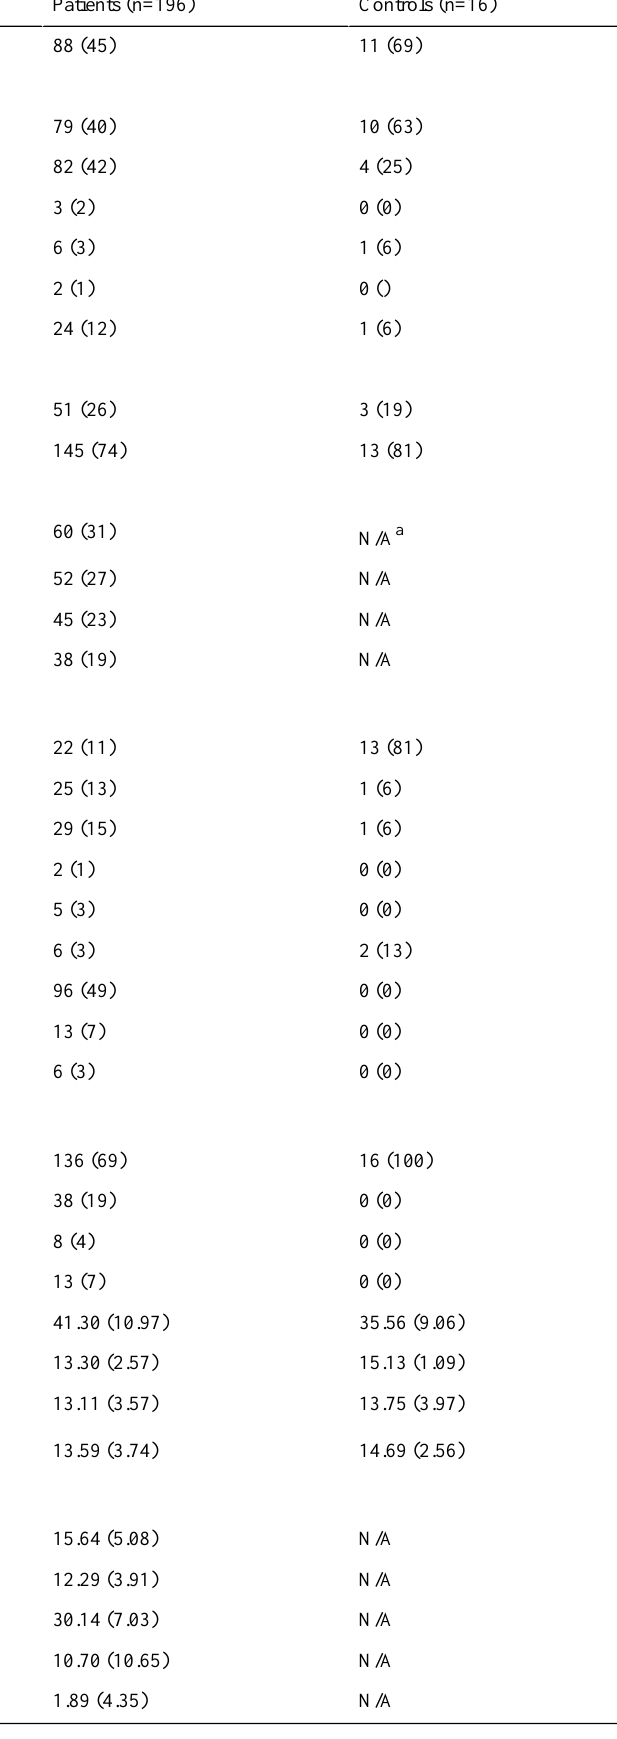
Table 1. Participant demographic and clinical characteristics from parent study